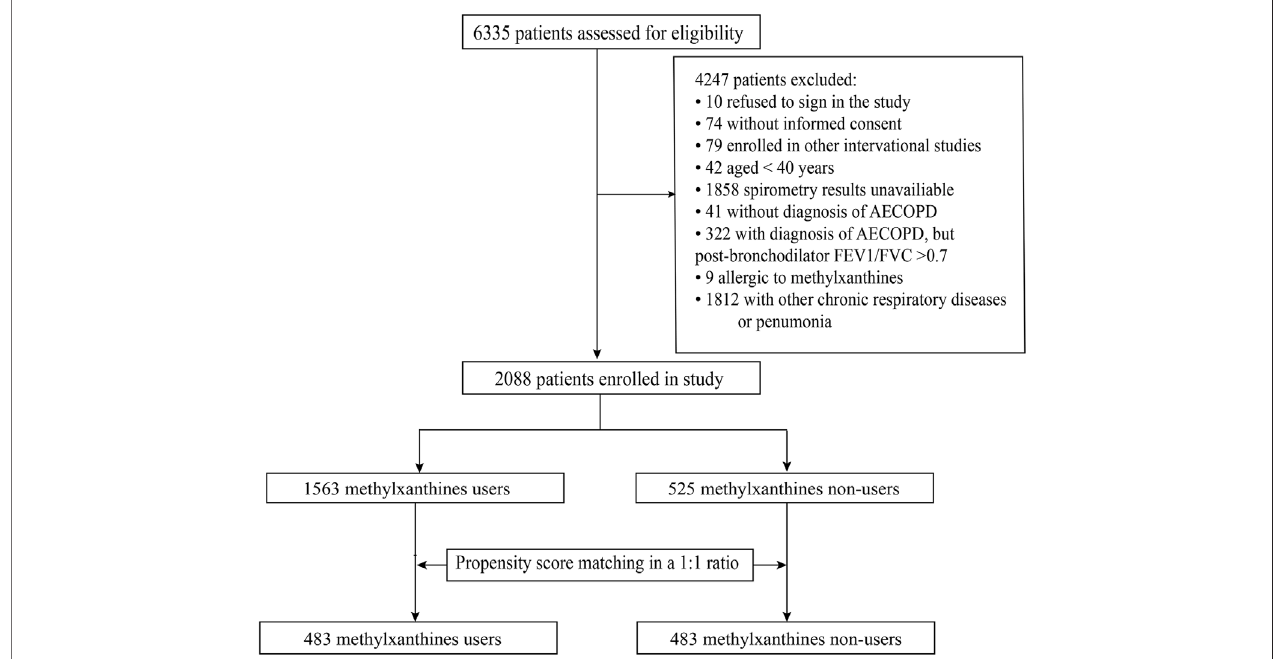
FIGURE 1 | The fl owchart of patient enrollment process. AECOPD, acute exacerbations of chronic obstructive pulmonary disease, FEV1/FVC, forced expiratory volume in one second/forced vital capacity.